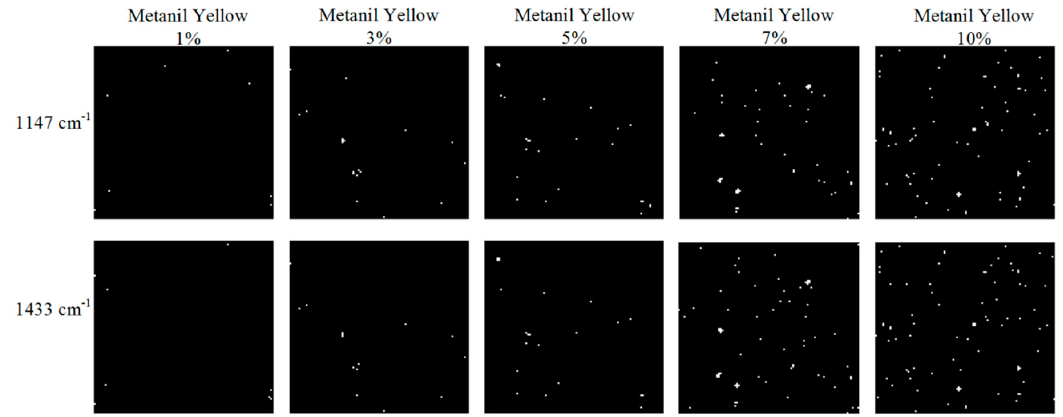
Figure 6. Single-band binary detection images of turmeric-metanil yellow mixture samples. Out of ten thousand pixels that were acquired from 10% concentration sample, 80 detected metanil yellow pixels correspond to 0.80% of total pixels. Similarly, in 1% concentration sample, 0.08% of total pixels were detected as metanil yellow. The percentage of detected metanil yellow pixels were correlated with its actual concentration in the sample with a correlation coefficient of 0.99 (Figure 7). The result shows a linear relationship between the metanil yellow concentration in the sample and the percentage of its detected pixels.